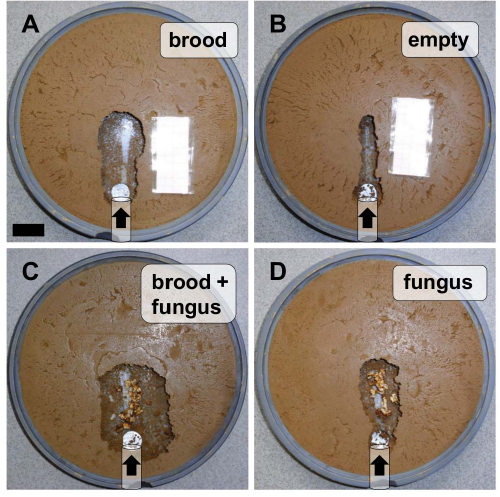
Figure 6. Pictures of digging sites at the end of the experiments. Experiment 5: (a) Brood. (b) Empty. Experiment 6: (c) Brood and fungus. (d) Fungus. Black bar=2 cm; black arrows indicate the direction of entering ants.